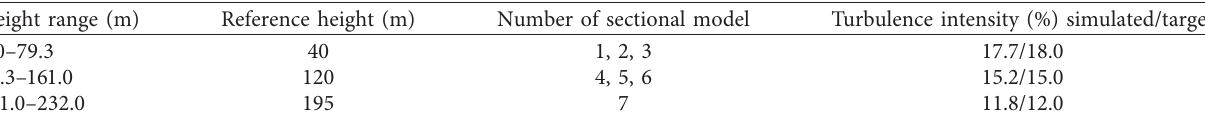
Figure 2: Grids with different air permeability. Table 2: Parameters of the simulated turbulent wind in the